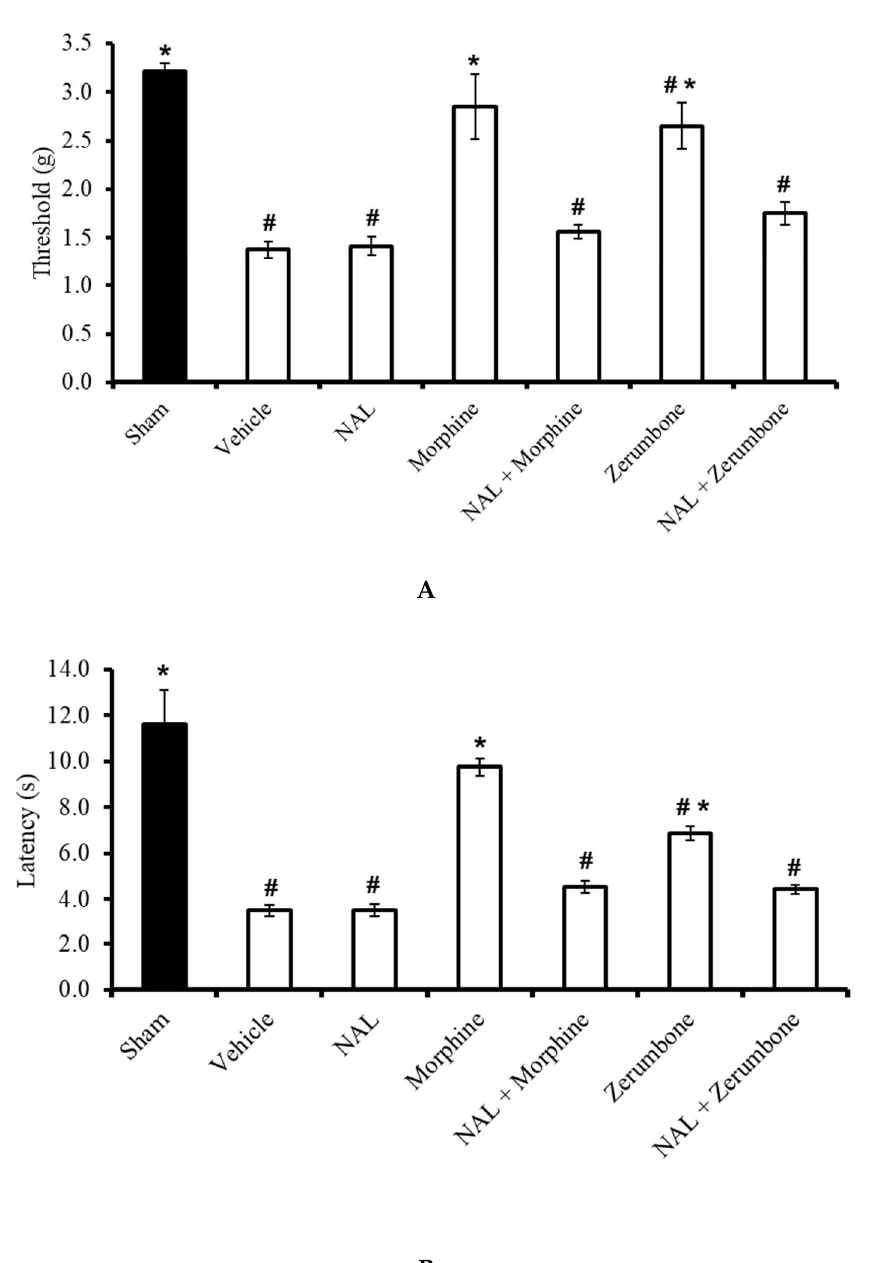
Figure 5. Effects of zerumbone (10 mg/kg; i.p.) and morphine (10 mg/kg; i.p.) and pre-treatment with a non-selective opioid receptor antagonist (naloxone, NAL; 10 mg/kg; i.p.) on the responses toward ( A ) mechanical allodynia and ( B ) thermal hyperalgesia on CCI-induced neuropathic pain in mice. Each column represents the mean ± SEM; n = 8 mice per group. Note: # significantly different ( p ≤ 0.05) than sham group; * significantly different ( p ≤ 0.05) than vehicle group (one-way ANOVA followed by Tukey’s post hoc test).